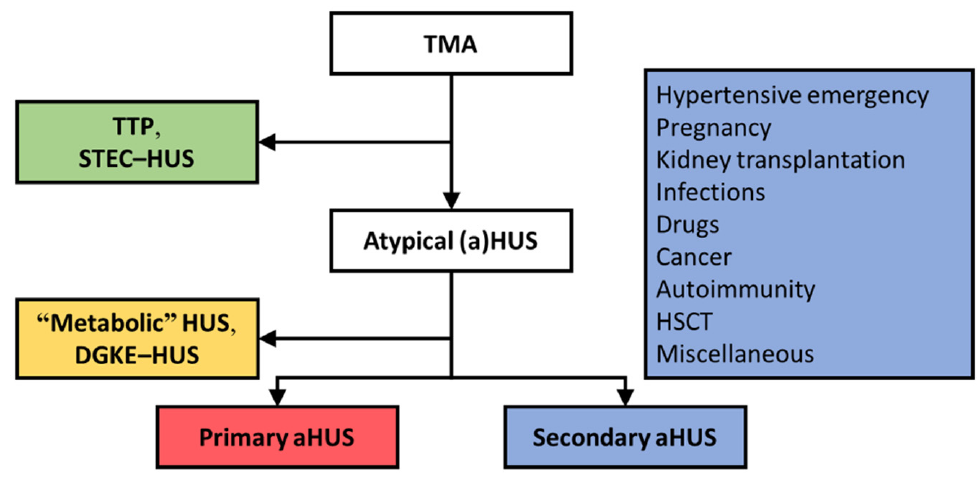
Figure 1. The atypical HUS-type classification [1,2].